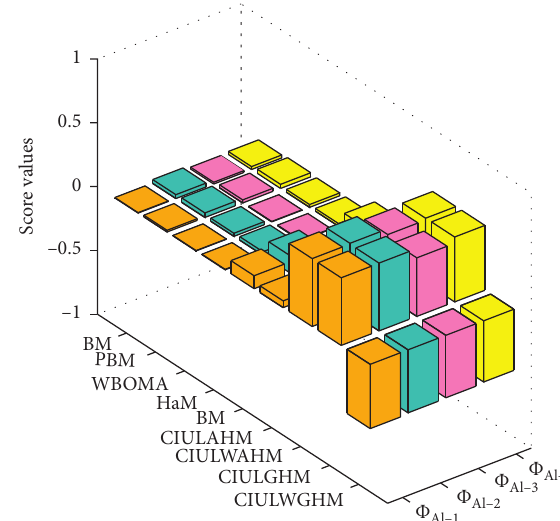
Figure 4: Geometrical interpretation of the information shown in Table